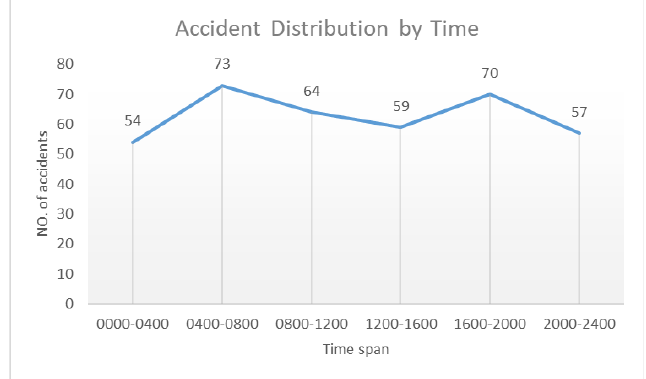
Figure 3. Accident distribution by time.